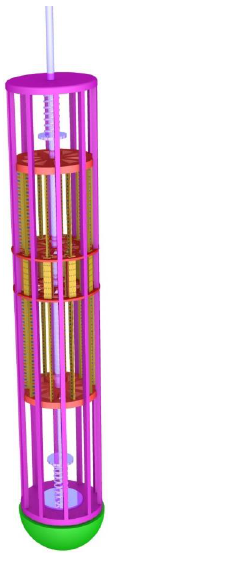
Figure 6. Cross-section of the inner buoy of DEIM Point Absorber.